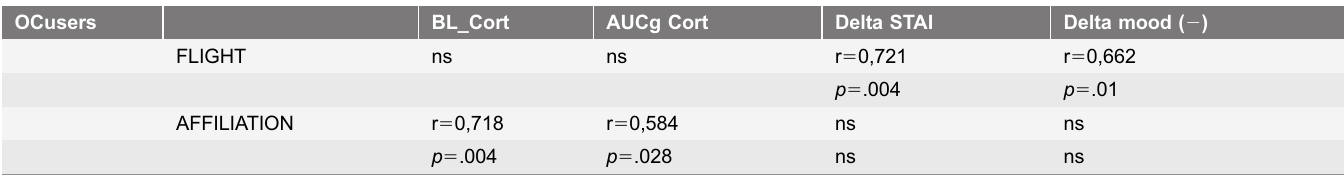
Table 4. Pearson correlations between psychophysiological basal levels and AUCg of cortisol, anxiety and mood reactivity with the behavioral patterns performed during the speaking task of the TSST (data from OCusers).